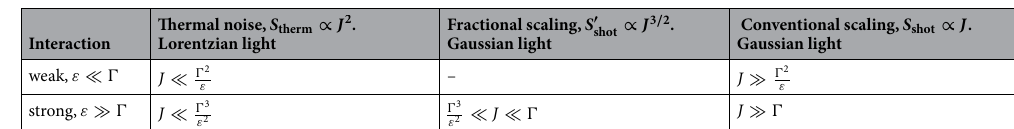
J γ for weak ( ε/Ŵ 0.1), intermediate ( ε/Ŵ 1) and strong ( ε/Ŵ ∝ = = = J as J increases. ( b ) Scaling exponent ∝ 2 to γ 3 / 2 as the interaction increases. = =